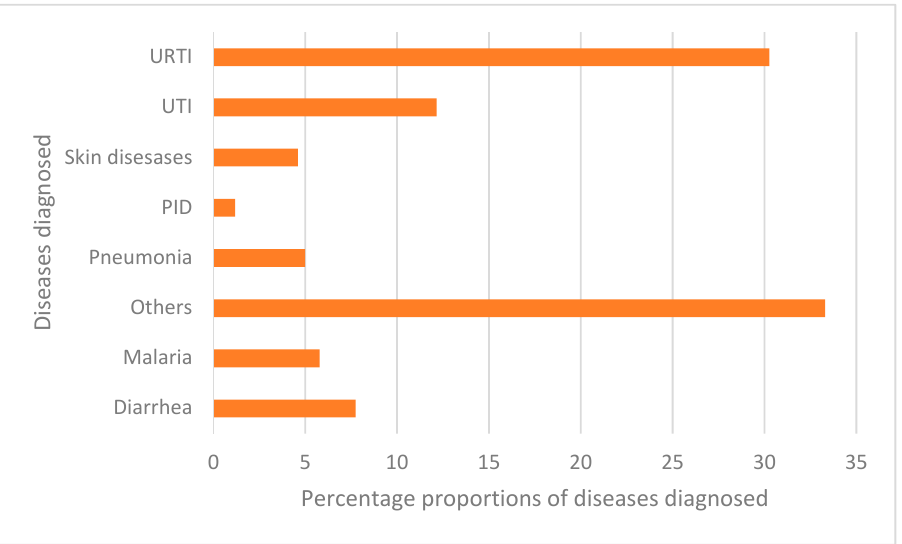
Figure 1. Proportions of individuals diagnosed with common diseases (Others: A group of conditions not presented in the chart).